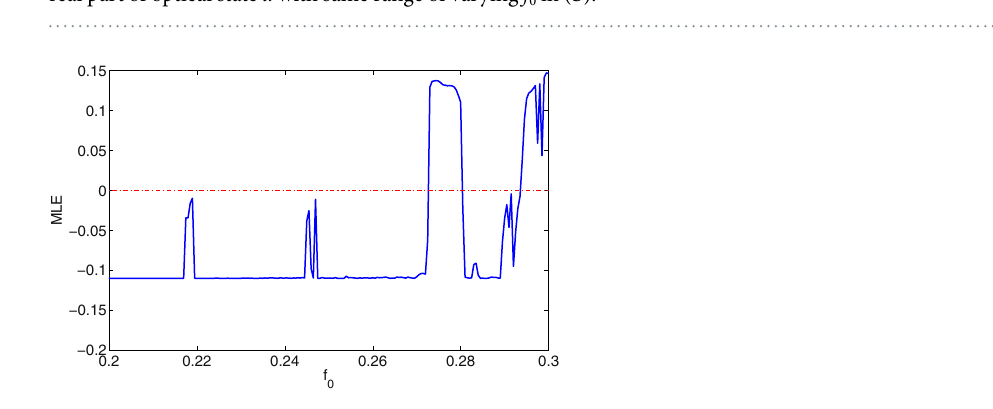
Figure 6. MLE of the system in double-driving mode with varying f 0 ∈ [0.2, 0.3]; Red dot line stands for Zero- standard line.